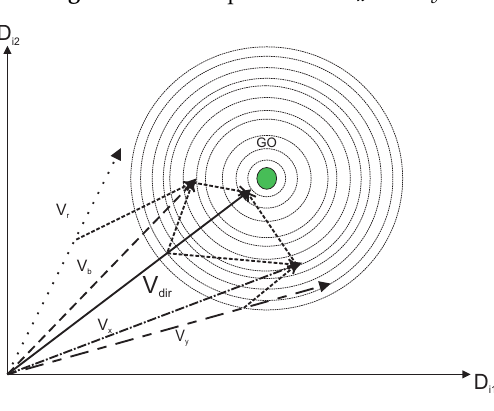
Figure 4. Direct cooperation